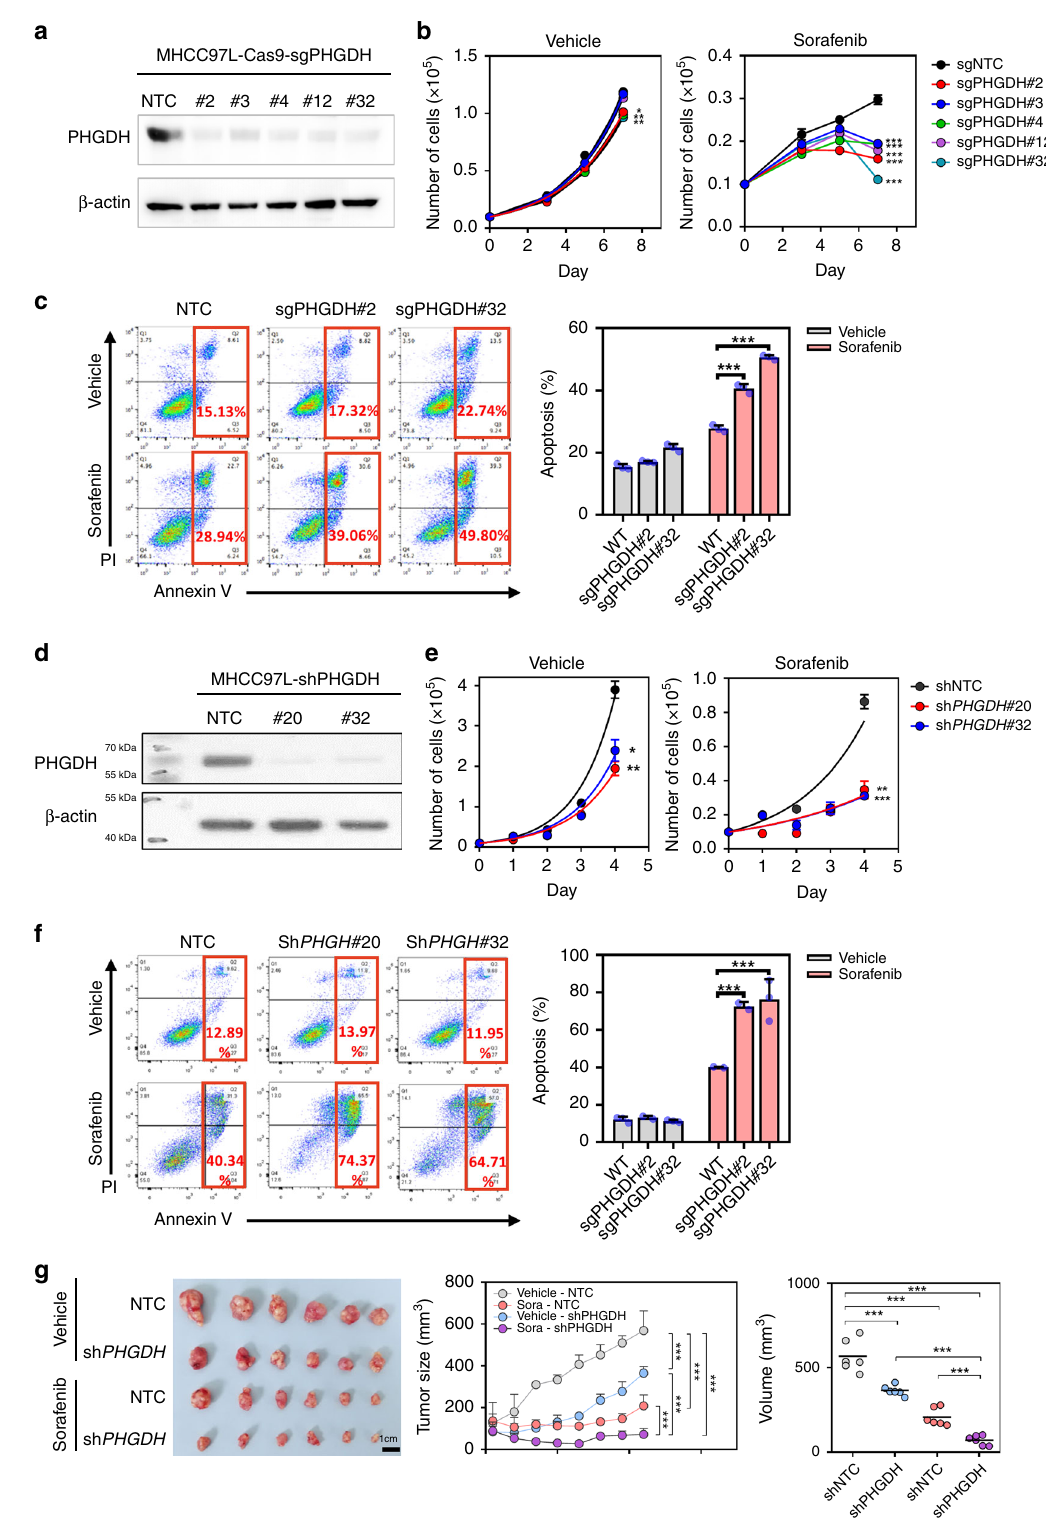
independent shRNA sequences (Fig. 3d). Consistently, shRNA- mediated knockdown of PHGDH recapitulated the sensitization effect of sgRNA-mediated KO in HCC cells towards Sorafenib treatment (Fig. 3e). PHGDH knockdown also dramatically induced apoptosis in the presence of Sorafenib (Fig. 3f). Next, we